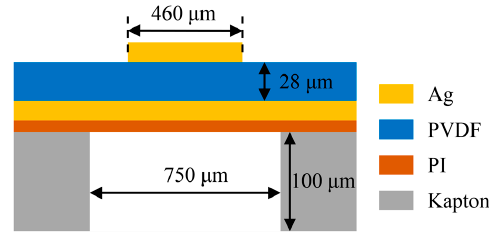
Figure 1. The schematic cross-section of the PMUT. Sensors 2020 , 20 , x FOR PEER REVIEW